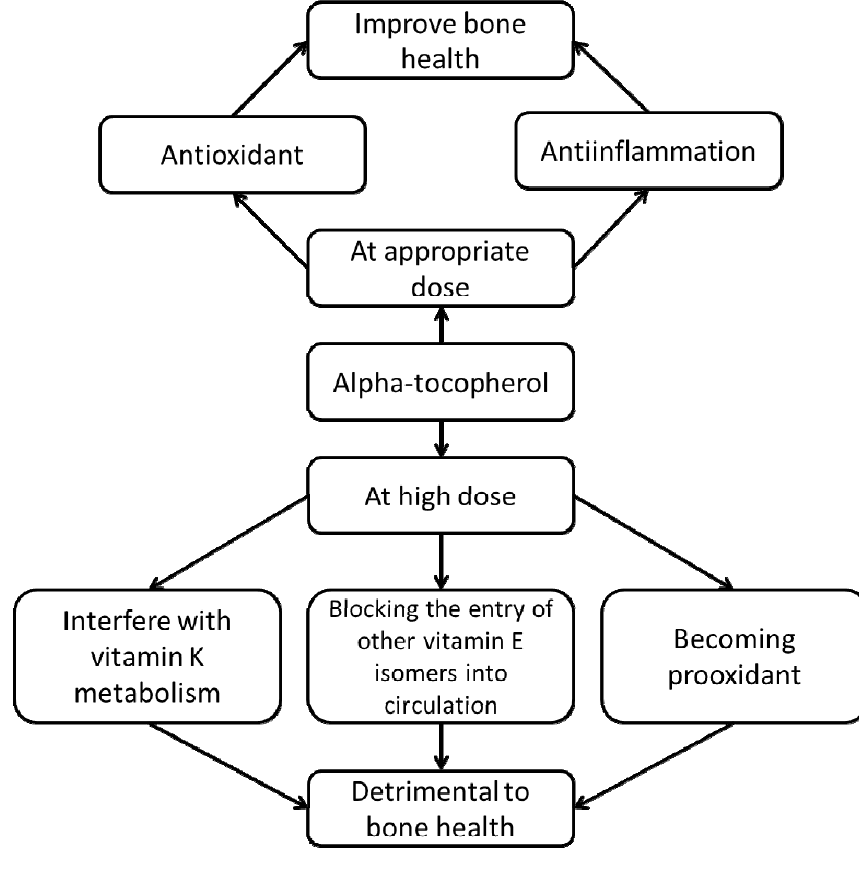
Figure 2. The proposed relationship between α -tocopherol and bone